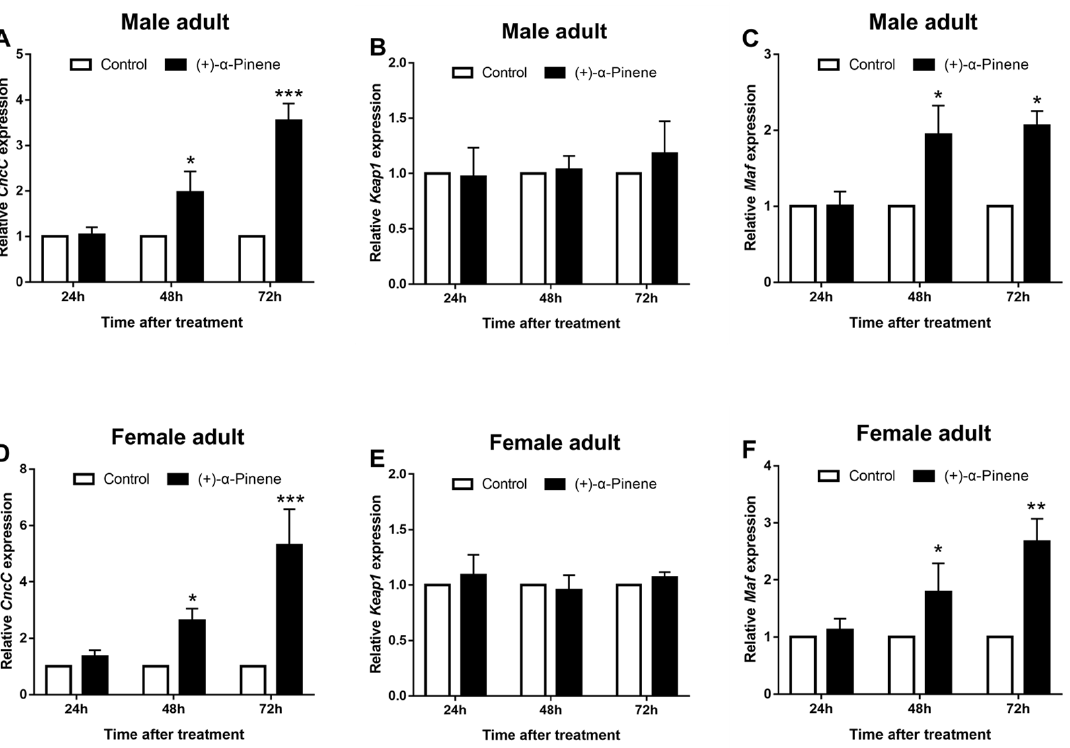
Figure 3. Relative expression levels of CncC ( A , D ), Keap1 ( B , E ), and Maf ( C , F ) in D. armandi emerged adults (sex separated) after stimulation with LC 50 (+)- α -pinene at exposure times of 24, 48, and 72 h. The asterisk indicates a significant difference between treatment groups (* p < 0.05, ** p < 0.01, *** p < 0.001, independent Student’s t -test). All values are the mean ± SE, n = 3.